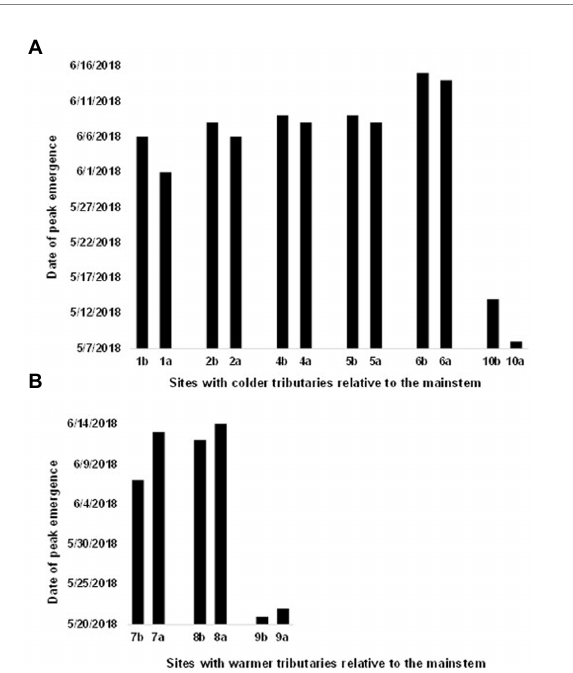
FIGURE 5 (A) Date of peak emergence across 22 sites in the Salmon River Basin as a function of modeled NorWeST temperatures. Temperatures ̊ C are categorized based on color categorizations from the modeled map: 1 = 12–14; 2 = 14–16; 3 = 16–18; 4 = 18–20, and range from cooler to warmer. Note that 22 points are not visible because several points overlapped. (B) Minimum temperature threshold associated with timing of salmonfly emergence at each reach-scale site in the Salmon River Drainage and Henry’s Fork of the Snake River Drainage, Idaho, United States in May–June 2018. Across these sites, peak emergence never occurred if water temperatures were below 8.4 ̊ C. Note that for this analysis, confluences 2, 3, 8, and 10 were excluded due to lack of temperature data on peak emergence